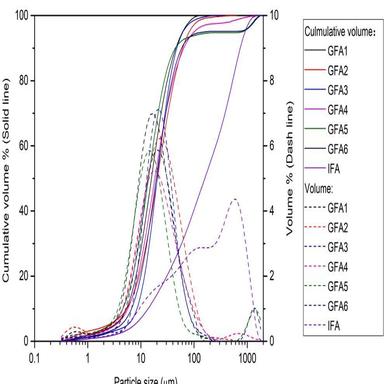
Particle size distributions of GFAs and IFA.